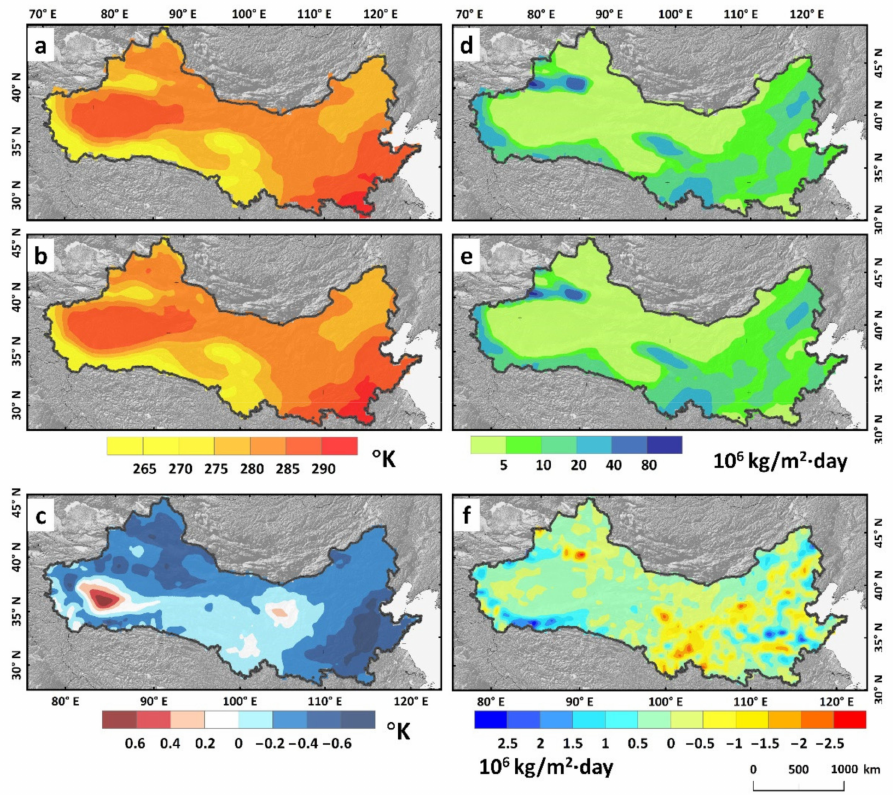
Figure 5. The variation in surface temperature and precipitation induced by spring dust aerosols during 2000–2015 in northern China. ( a ) Scenario B1: Surface temperature under the effect of dust aerosols; ( b ) scenario B2: Surface temperature without considering dust aerosols; ( c ) the difference between B1 and B2, indicating the change in temperature caused by dust aerosols; ( d ) scenario B1: Precipitation under the effect of dust aerosols; ( e ) scenario B2: Precipitation without considering dust aerosols; ( f ) the difference between B1 and B2, indicating the change in precipitation caused by dust